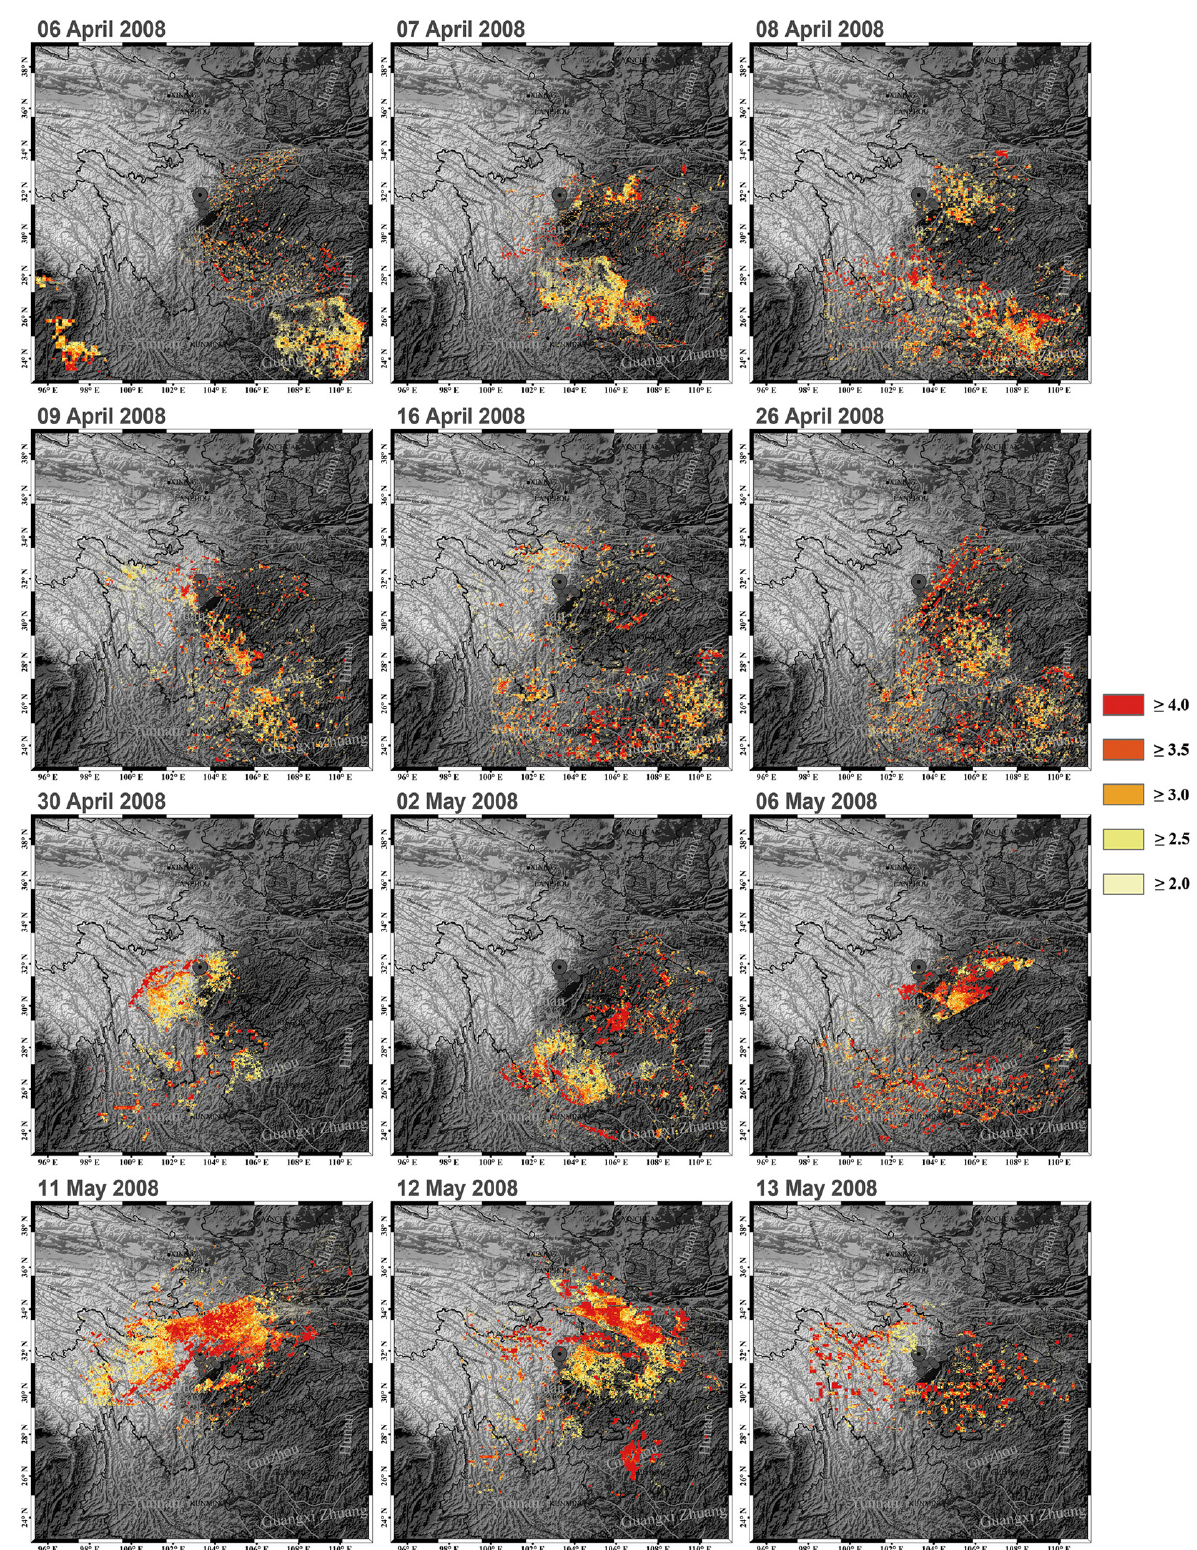
Figure 6. Results of the RETIRA index computation on the investigated area before and after the Wenchuan earthquake using AATSR BT data (Forward view) from April 6, 2008, to May 13,